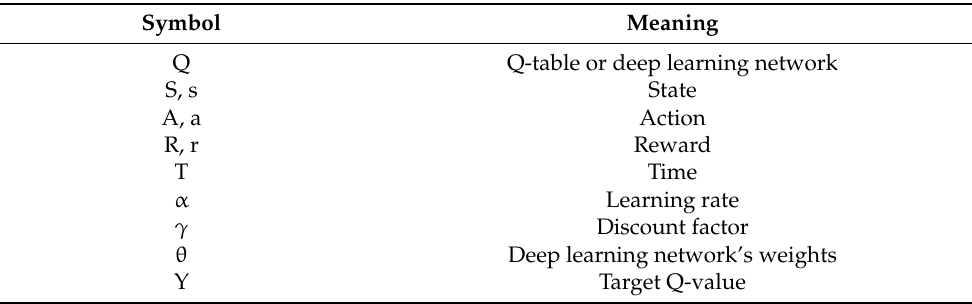
Table 1. Symbols used in